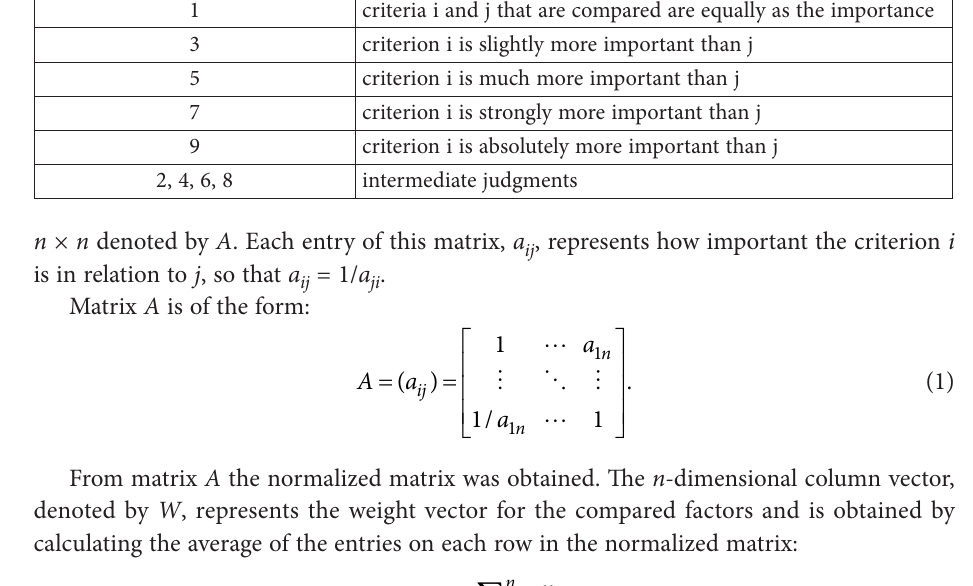
Table 3. Saaty’s scale for pairwise comparisons (source: Saaty, 1980) Intensity of